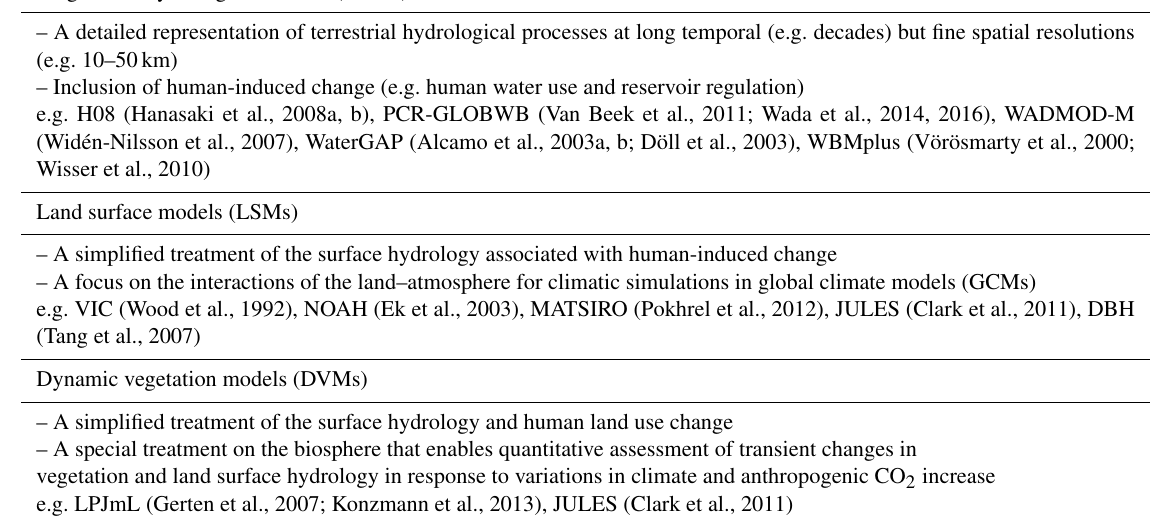
Table 1. Types of models used to simulate global hydrology. Large-scale hydrological models